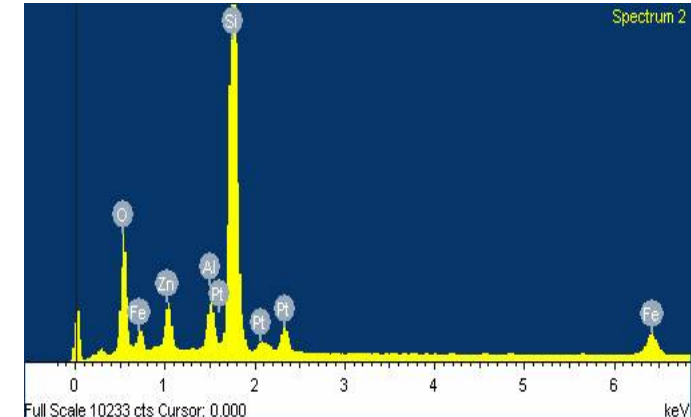
Figure 1. SEM analysis of the AlZnFe